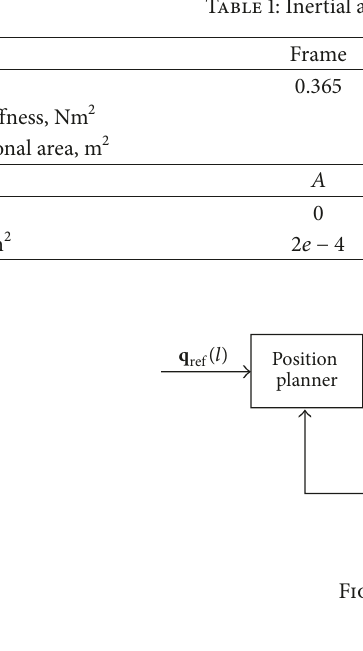
Table 1: Inertial and geometrical parameters of the four-bar linkage.